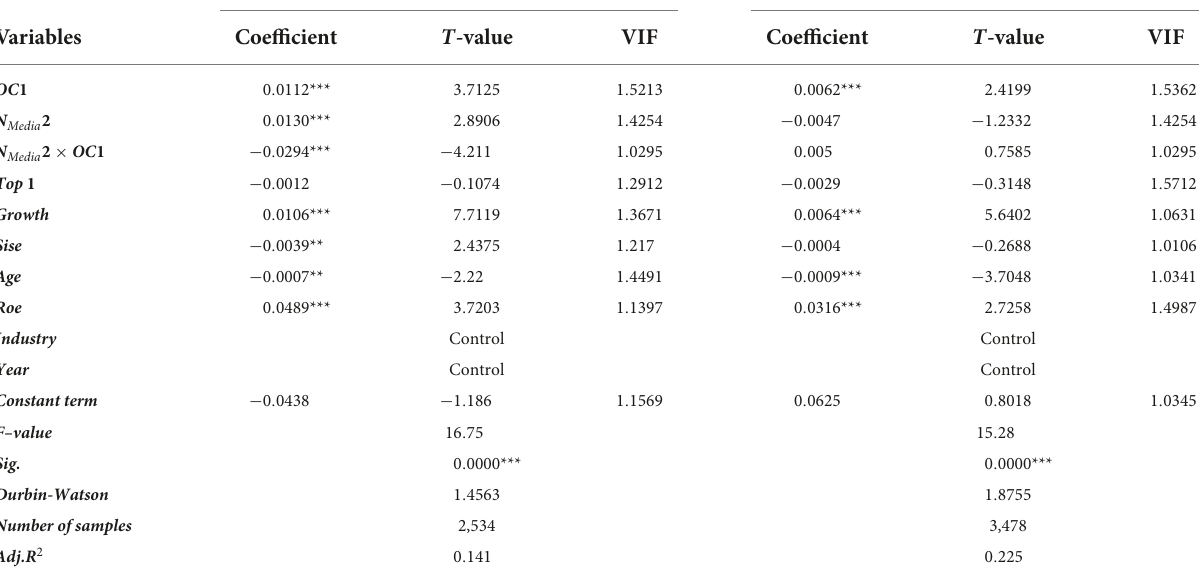
TABLE 12 Regression results of negative media reports under different